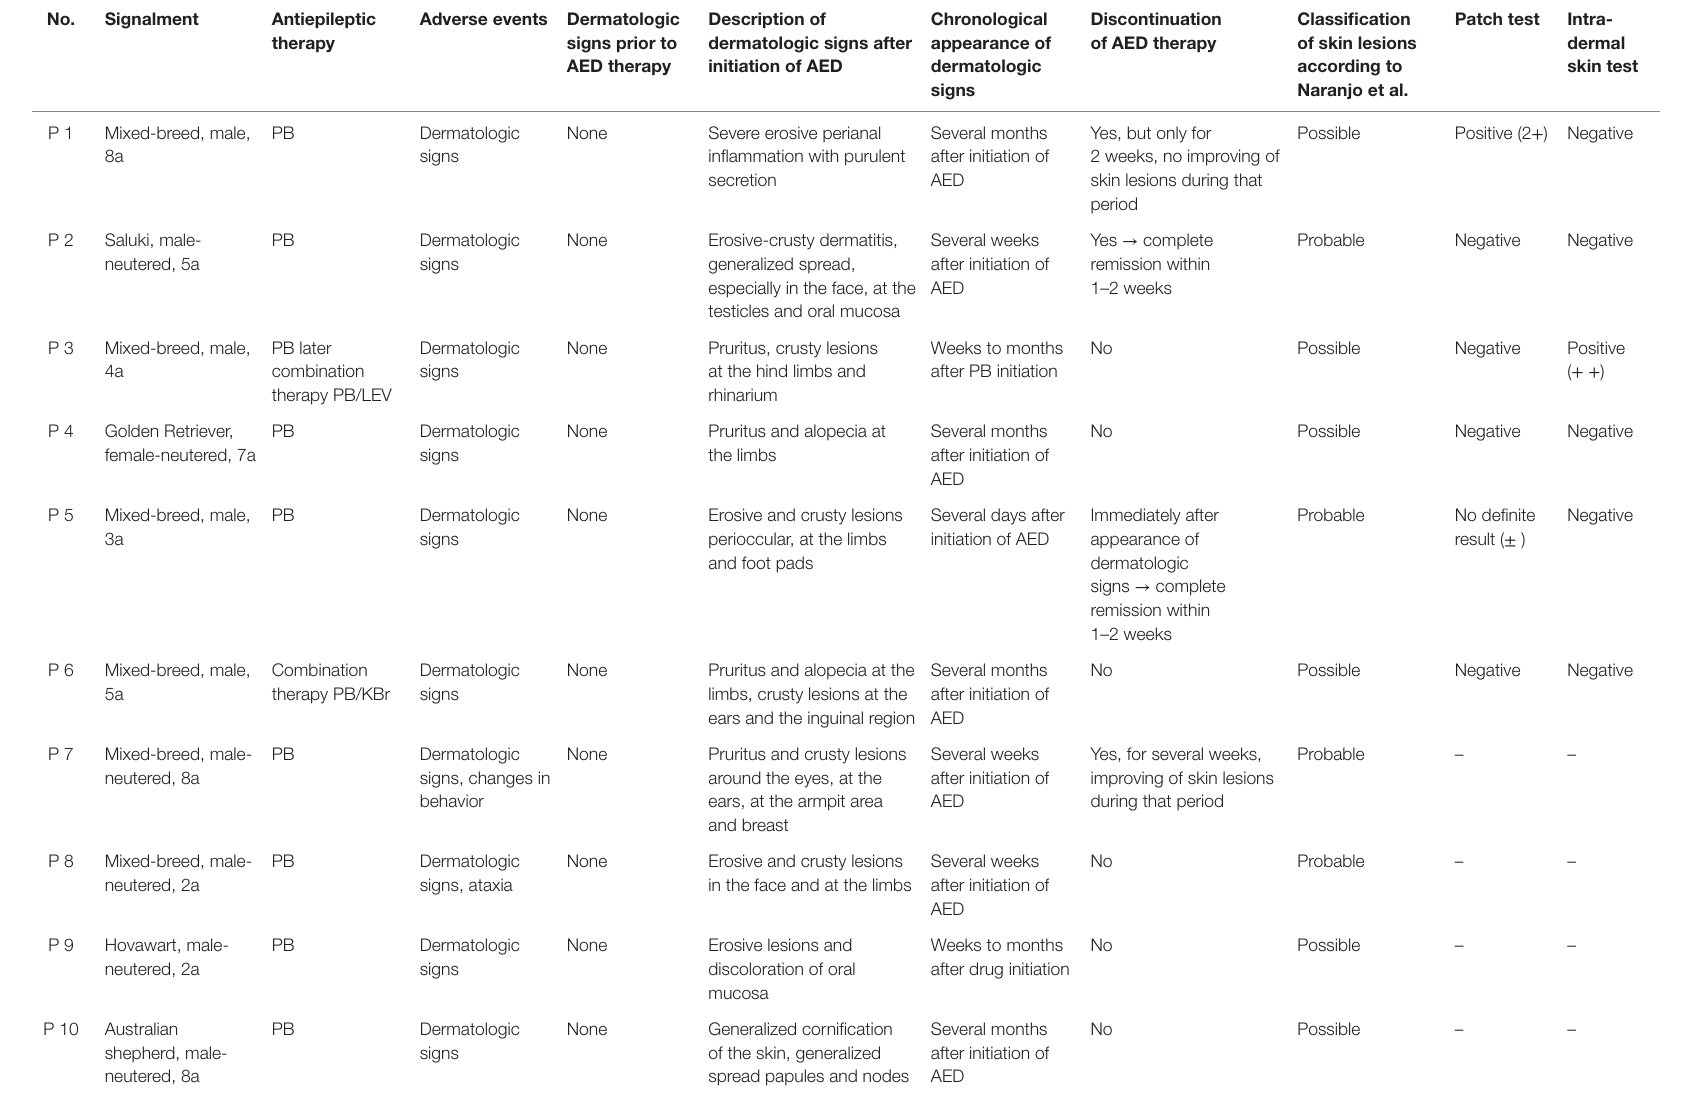
TaBle 5 | Prospectively collected cases of skin lesions under antiepileptic treatment.